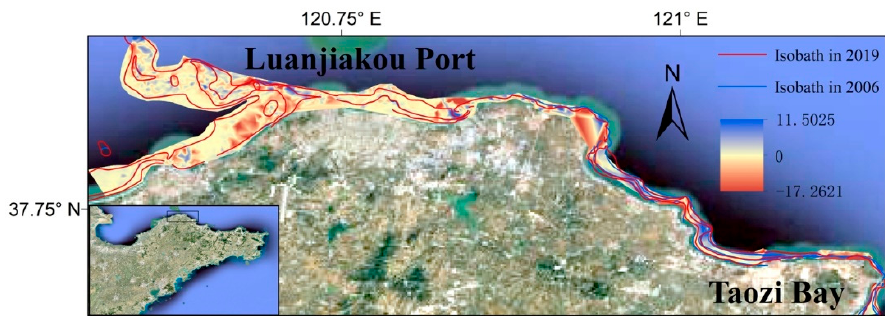
Figure 7. Isobath and scouring–siltation changes between Luanjiakou Port and Taozi Bay.